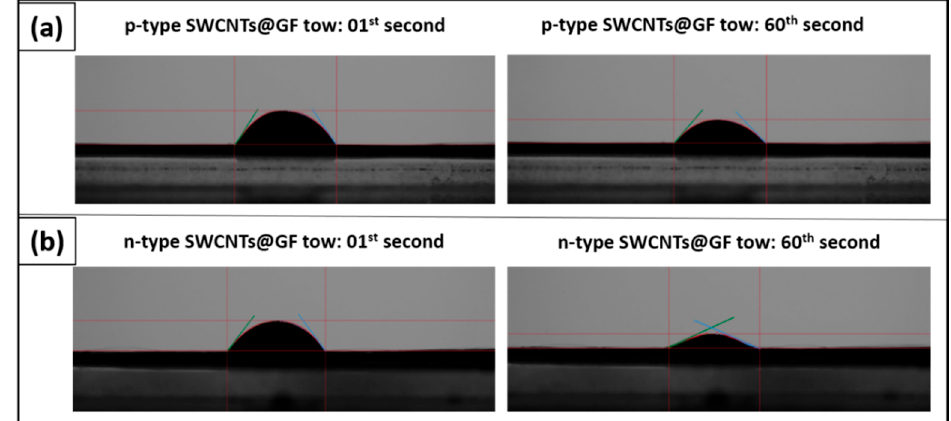
Figure 3. Static contact angle images measured by a goniometer’s software for ( a ) p-type single walled carbon nanotubes (SWCNTs) dispersion droplet in contact with glass fiber tow and ( b ) n-type SWCNTs dispersion droplet in contact with glass fiber tow.